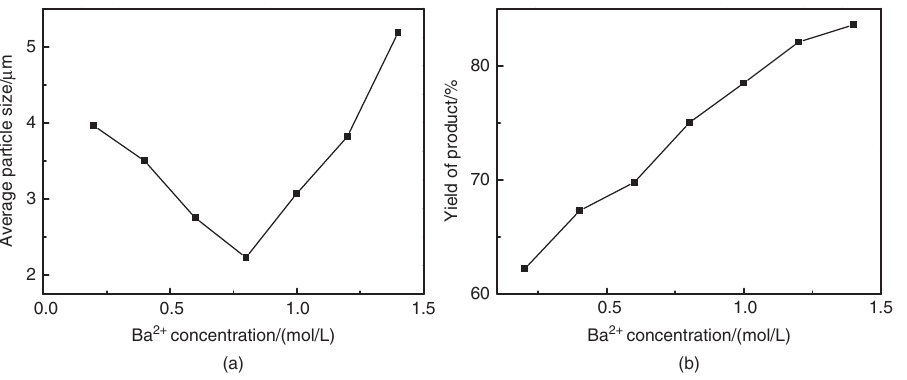
Figure 2: Effect of Ba 2 þ concentration on average particle size (a) and yield of product (b) in the microwave homogeneous precipitation,